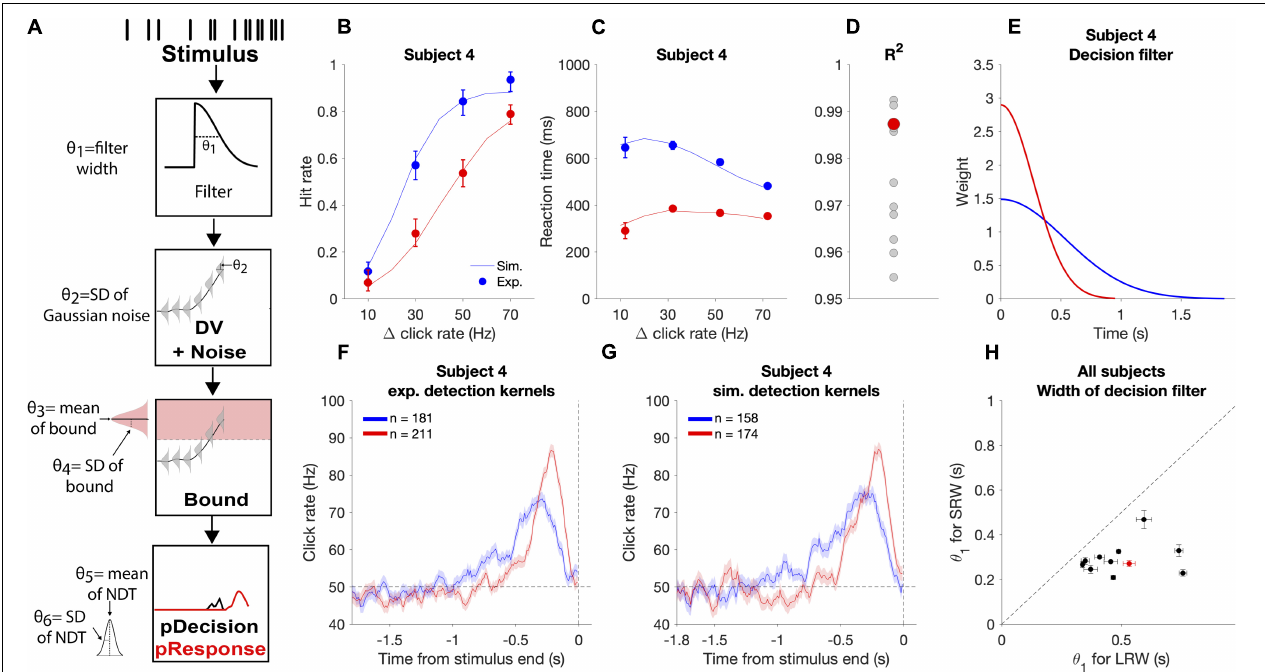
FIGURE 5 | Modeling the decision process for the auditory change detection task. (A) Schematic of how the model estimates response time probabilities for single trials. Stimuli were convolved with a half-gaussian decision filter to generate the mean DV. Next, gaussian noise was added to the DV. The probability of decision commitment as a function of time was calculated based on the probability of crossing a bound with a variable height. Finally, a variable non-decision time is added to get the response time. (B,C) Experimental psychometric and chronometric data from subject four (data points) compared to model predictions using best fit parameters (lines). (D) Goodness of fit for each individual subject with subject four highlighted in red. (E) Changes in the best fit decision filter based on task condition for subject four, with a narrower filter in the SRW condition, (F) Experimental detection report kernels for subject four and (G) detection report kernels simulated from the best fit model for that subject with the same number of trials as the experimental data. (H) Pairwise comparison of the best fit decision filter width parameter ( θ 1 ) in the SRW vs LRW condition for each subject. Data from subject four is outlined by the red rectangle. Error bars indicate standard error of the estimated width